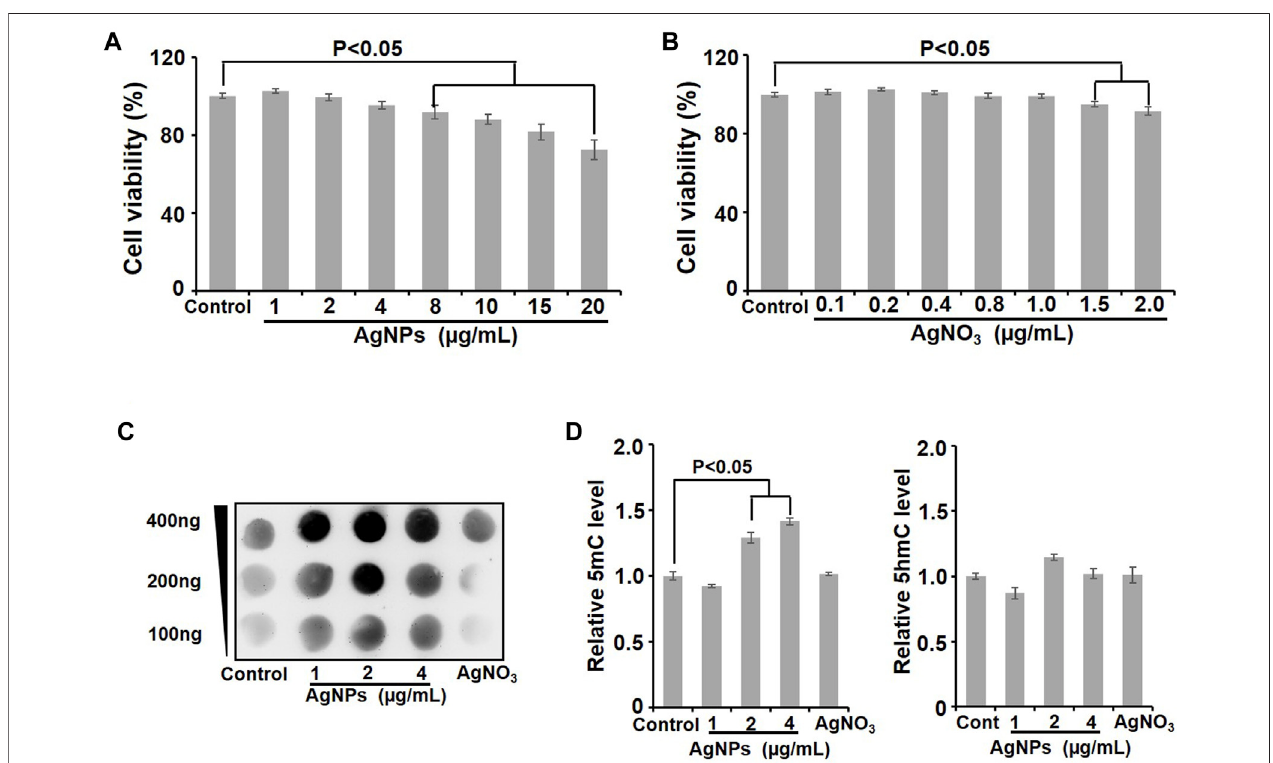
FIGURE 2 | Cell viability evaluation and DNA methylation detection in HEK293T cells after AgNPs exposure. (A) Cell viability was detected with the Alamar Blue assay in HEK293T cells exposed to AgNPs at different concentrations for 24 h ( n = 6). (B) Cytotoxicity was examined in HEK293T cells dealt with Ag ions at various concentrations for 24 h through the Alamar Blue assay. (C) Dot-blotting analysis of 5-mC values in HEK293T cells upon exposure to AgNPs at different concentrations for 24 h. (D) Relative quantitative analysis of 5-mC and 5-hmC levels in genomic DNA detected by UPLC-MS/MS in HEK293T cells upon AgNPs exposure at various concentrations for 24 h (n = 3 –